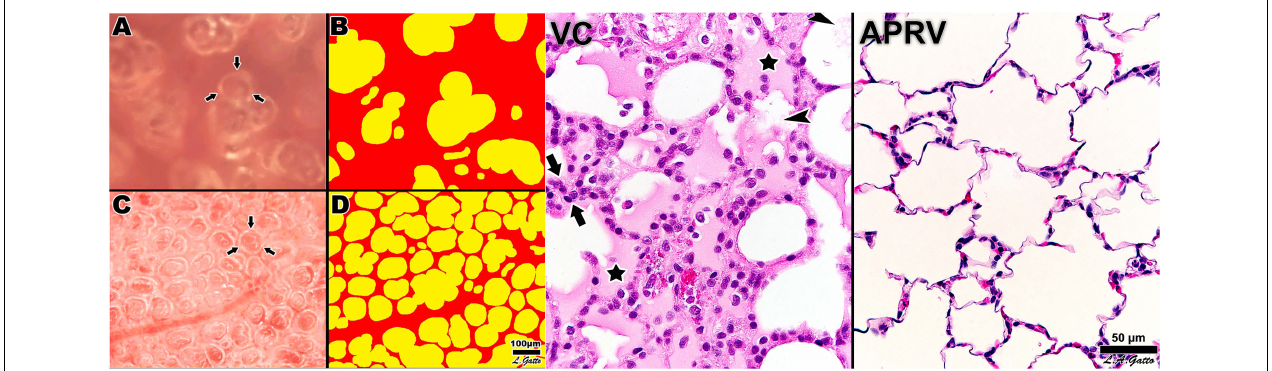
FIGURE 10 | Left – Subpleural alveoli seen using in vivo microscopy in a rat hemorrhagic shock-induced ARDS model ventilated with volume cycled ventilation ( VC ; A,B ) or airway pressure release ventilation ( APRV ) using the time controlled adaptive ventilation (TCAV) method ( APRV ; C,D ). Individual alveoli are shown by arrows. Inflated alveoli were color coded yellow, and alveolar number, size, and surface area were measured by computer image analysis in each group. TCAV significantly improved alveolar patency and stability as compared with the VC group. Right – The APRV group delivered using the TCAV method stabilized alveoli that was associated with a significant reduction in lung histopathology as evidenced by open alveoli and reduced intra-alveolar edema (purple areas) as compared with the collapsed and edema-filled alveoli (stars), fibrinous deposits in the air compartment (arrowheads), and white cell infiltration (between arrows) in the VC group (Roy S.K. et al., 2013). Permissions obtained from Wolters Kluwer Health, Inc. License